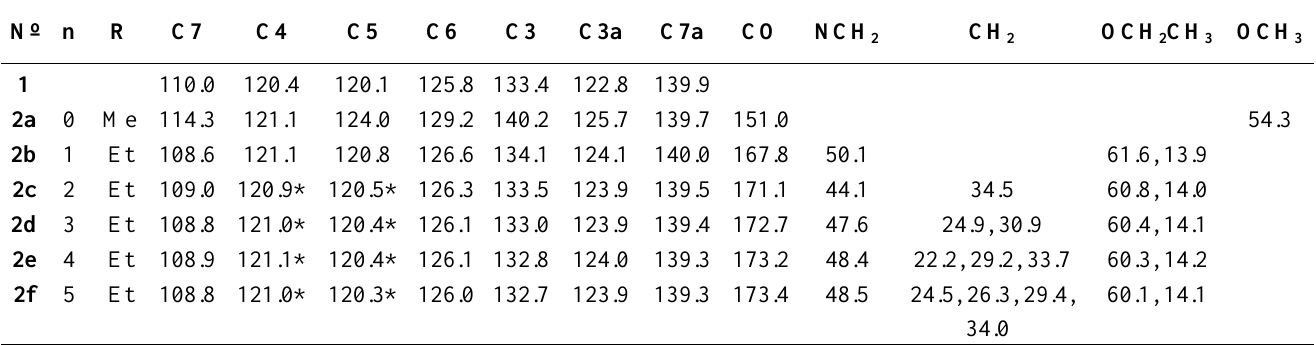
Table 4. 13 C-NMR chemical shifts ( δ in ppm) of 1 H -indazole 1, 1 H -indazole esters 2a-i and 2 H -indazole esters 3b-i in CDCl 3